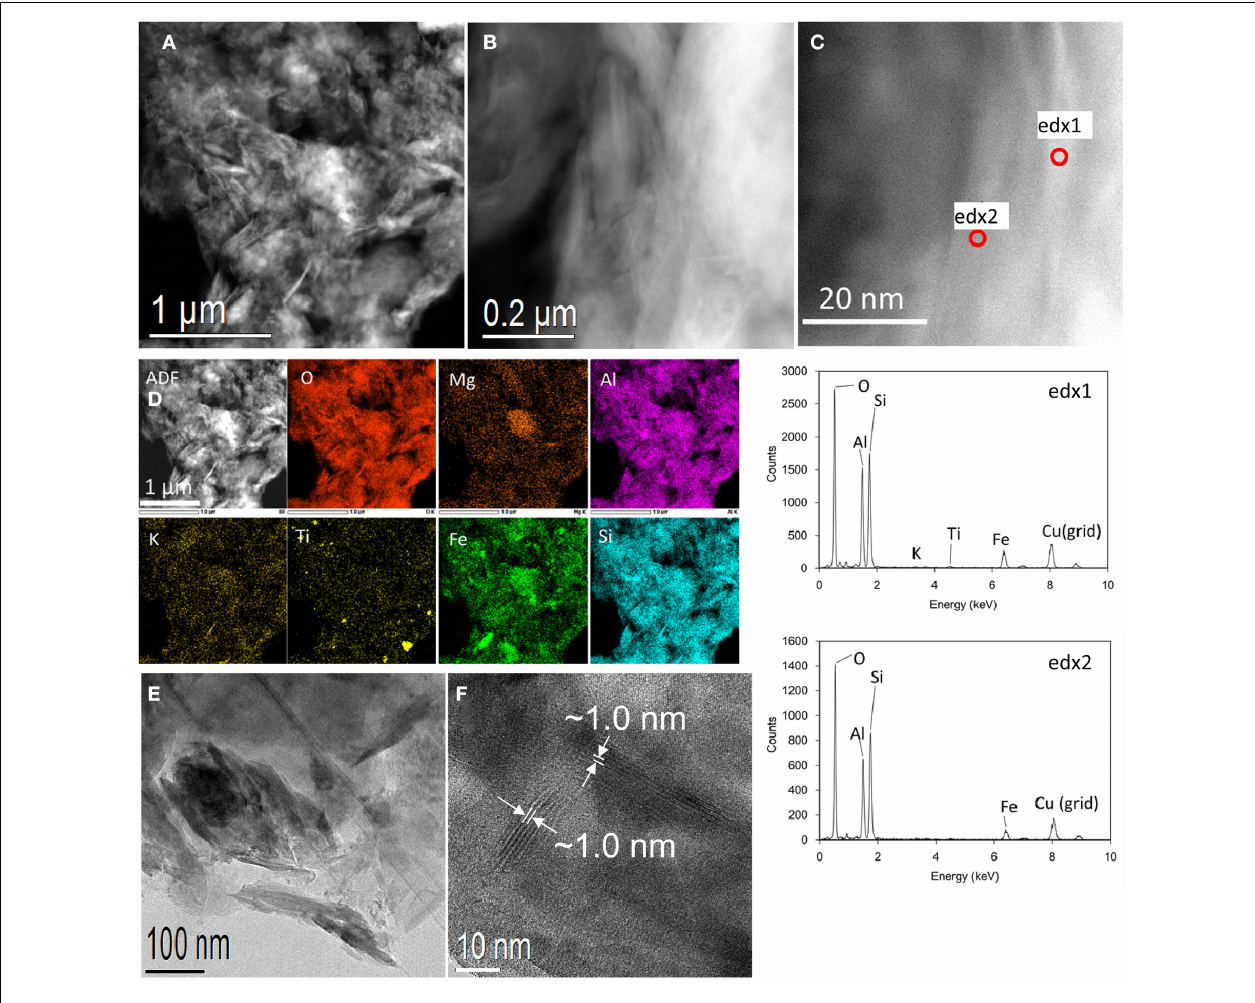
FIGURE 7 | Results of TEM analyses of the submicron-sized particles elutriated from OTO-E . (A–C) HAADF-STEM images of an aggregate of the submicron-sized particles. (A) A wide view, (B) an enlarged image of (A) showing flaky-shaped particles, and (C) a further